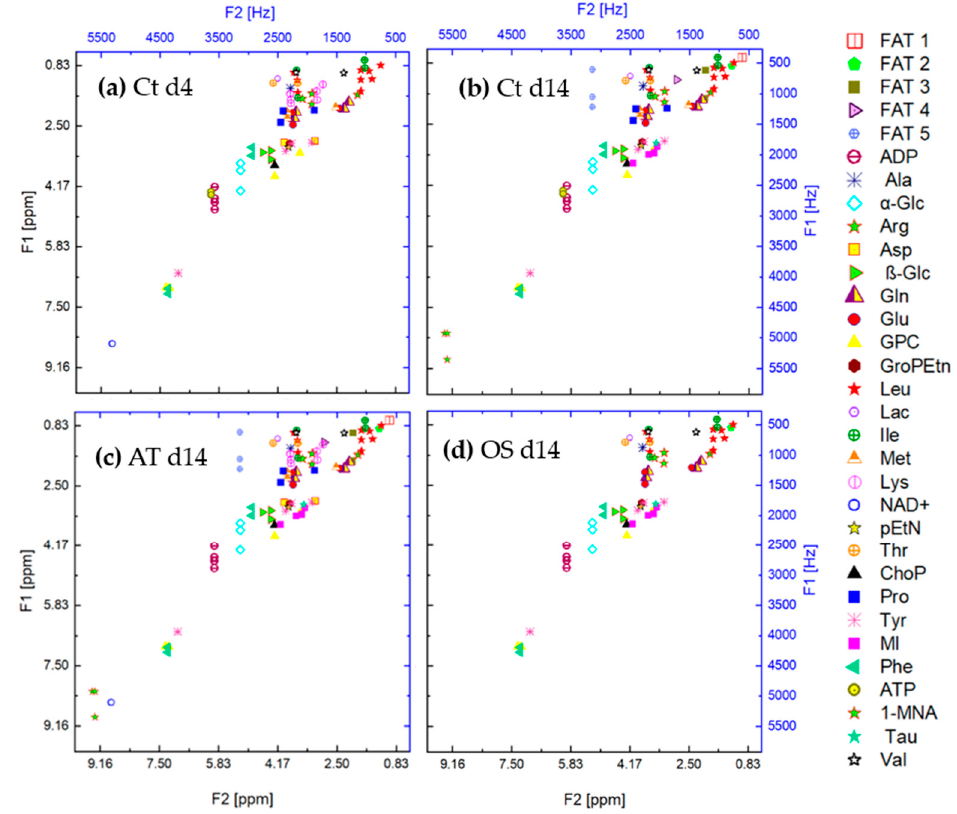
Figure 4. Feature space of the cross peaks of the metabolites contained in the samples ( a ) Ct d4, ( b ) Ct d14, ( c ) AT d14 and ( d ) OS d14.